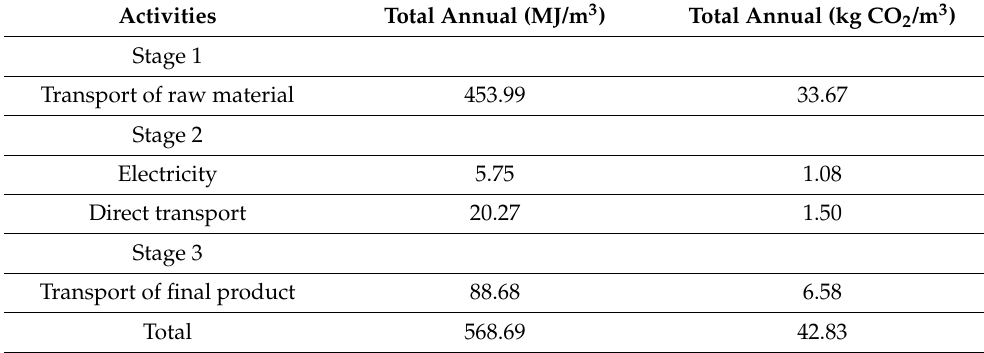
Table 1. Embodied energy and CO 2 emissions in each stage of the ready mixed concrete production.